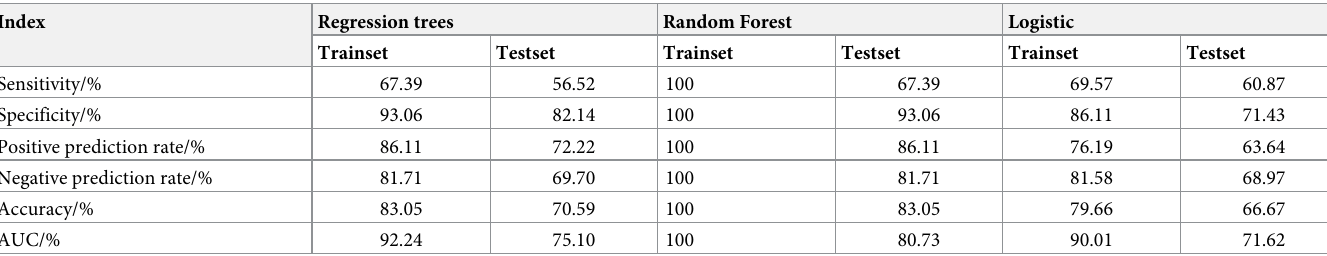
Table 4. Comparison of regression trees, random forest and logistic model performance in the training set and test